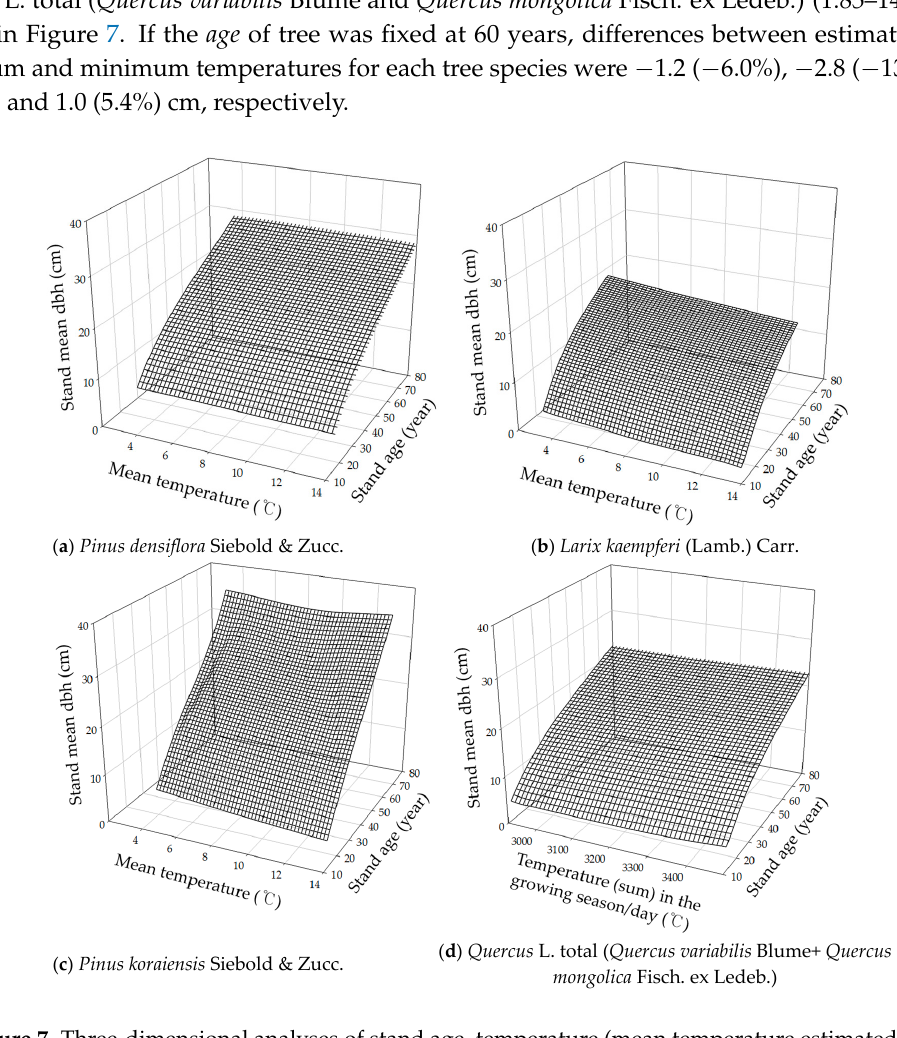
Figure 7. Three-dimensional analyses of stand age, temperature (mean temperature estimated over a 13-year period for coniferous forests and in growing seasons for oak forests) and diameter at breast height (DBH).